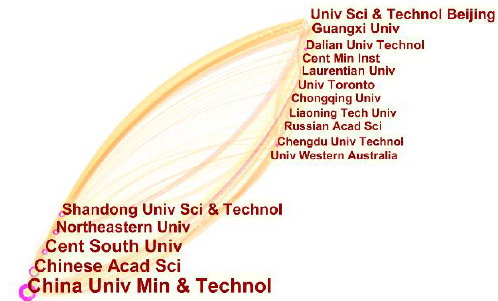
Figure 2. Institution cooperation network for rockburst research.